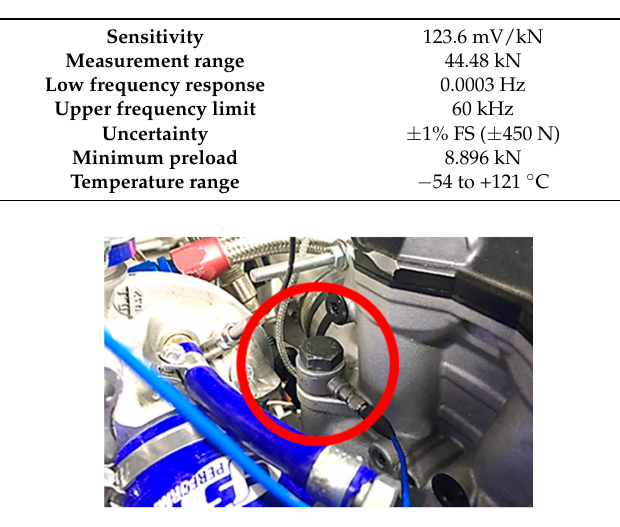
Figure 2. Strain washer installation on engine